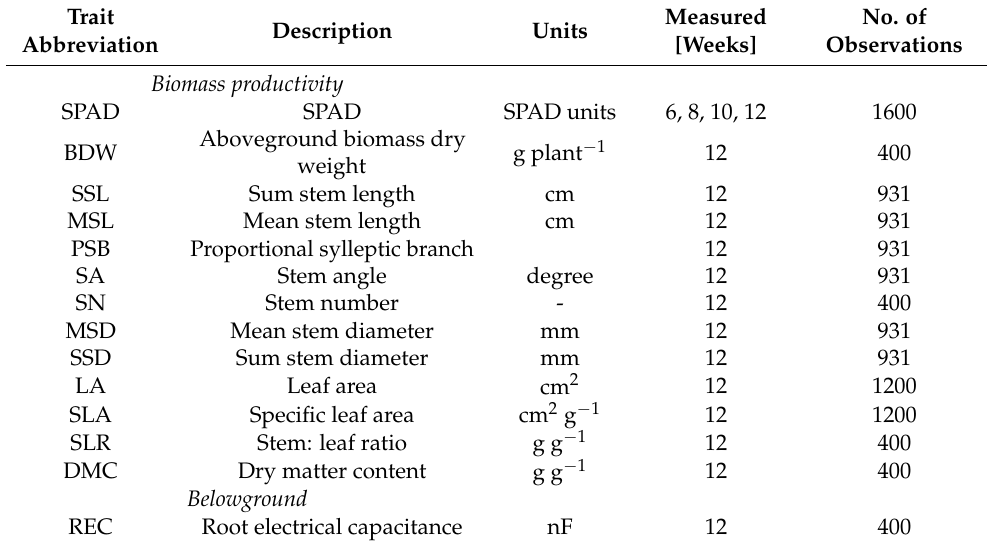
Table 1. List of biomass-related variables including their descriptions and